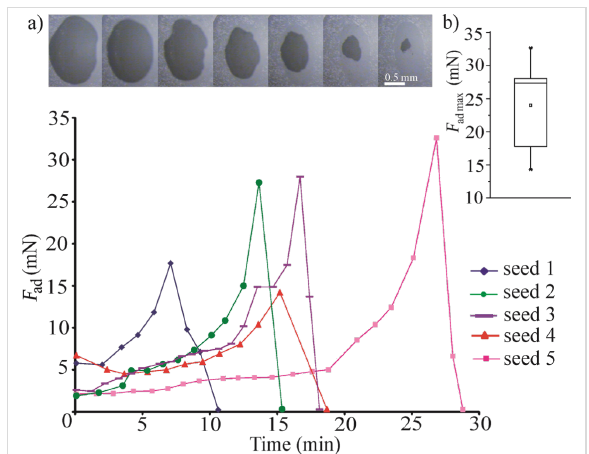
Figure 3: Adhesion force ( F ad ) of mucilaginous seeds measured at dif- ferent degrees of desiccation after full hydration. (a) Dynamics of the adhesion force is shown for five individual seeds. The top inset of microscopic images illustrates the decreasing contact area of one indi- vidual seed with the glass block under load during pull-off measure- ments. Interestingly, the adhesion–time curves of the individual seeds are comparable; (b) Box-and-whisker diagram of the mean maximum adhesion force of measured seeds, where the bottom and top of the box are the 25th and 75th percentiles, the band inside the box is the median; the ends of the whiskers are the 10th and 90th percentiles.